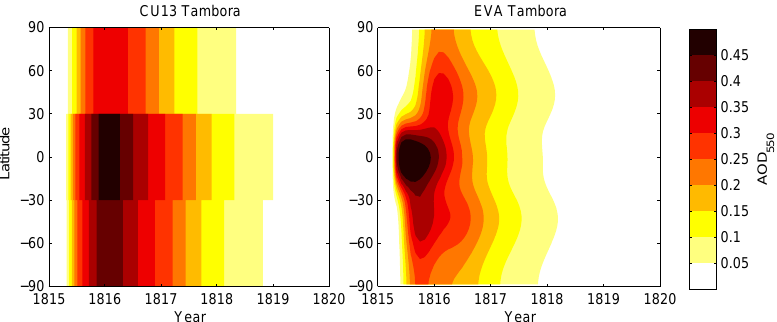
Figure 17. Zonal mean AOD 550 for the Tambora eruption from (left) CU13 and (right)